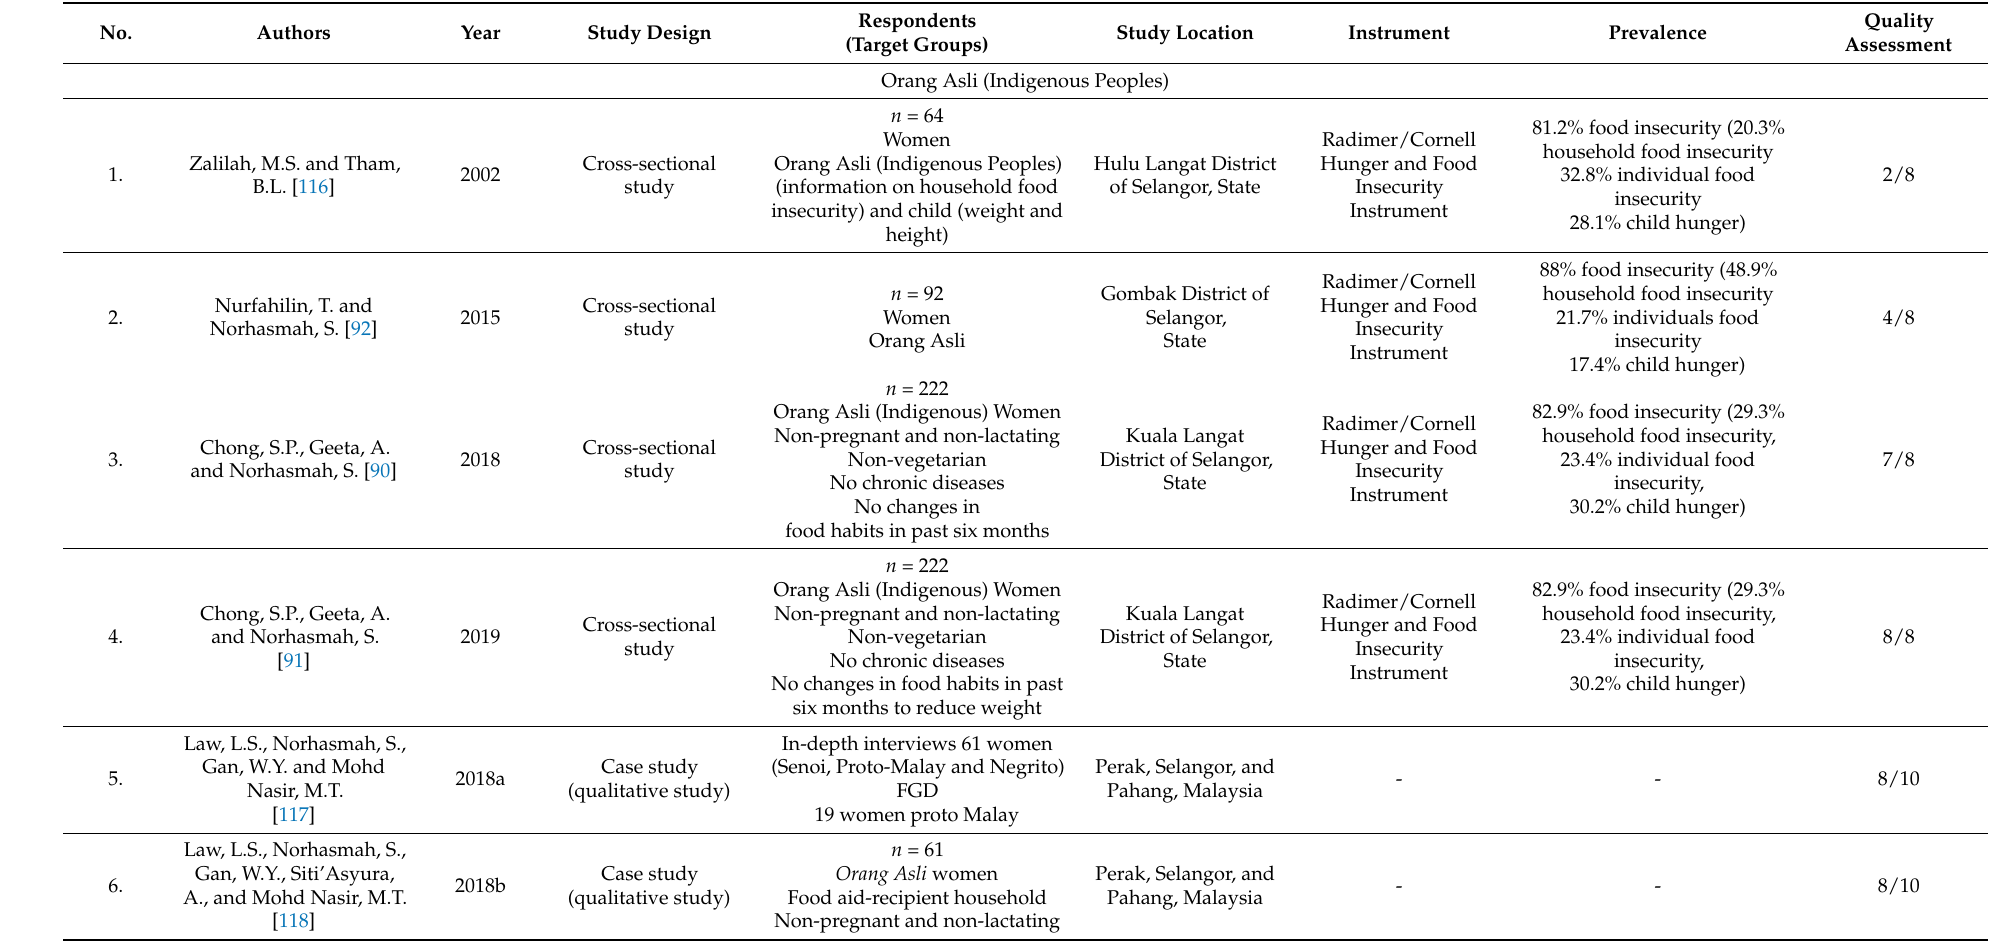
Table 3. Prevalence of and groups at risk of food insecurity in